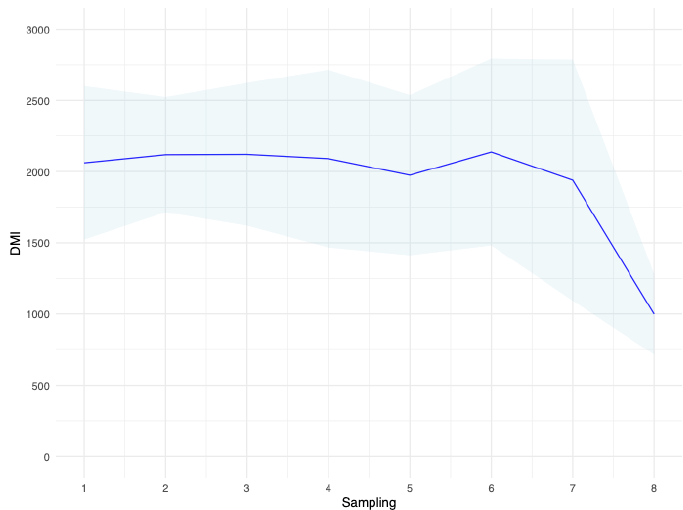
Figure 2. Average dry matter intake (blue line) and its standard deviation (light-blue region) across the eight samplings.